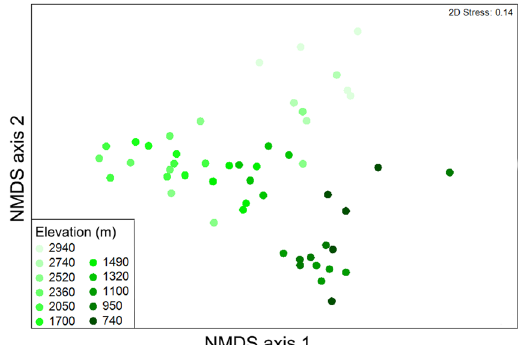
Figure 4. NMDS of Bray Curtis similarity of overall community structure in relation to elevation.